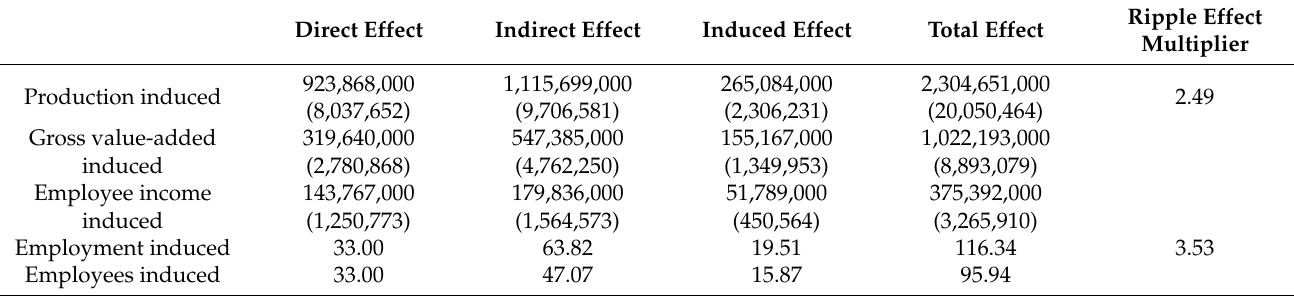
Table 2. Economic ripple effects of the CLT manufacturing sector (unit: JPY (USD), people).